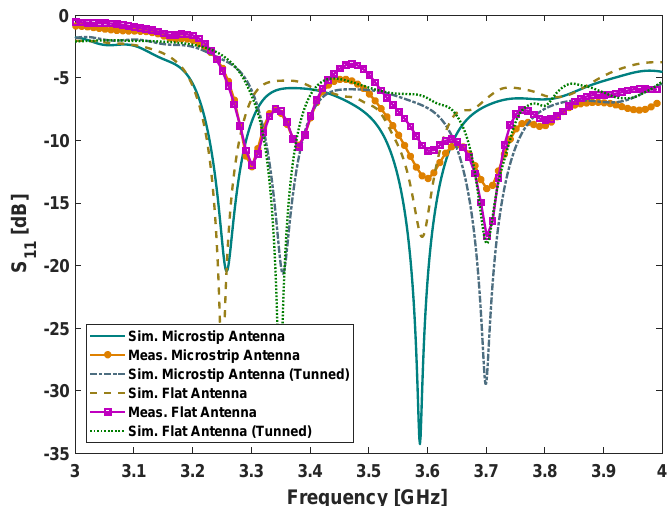
Figure 8. Simulated and measured S 1,1